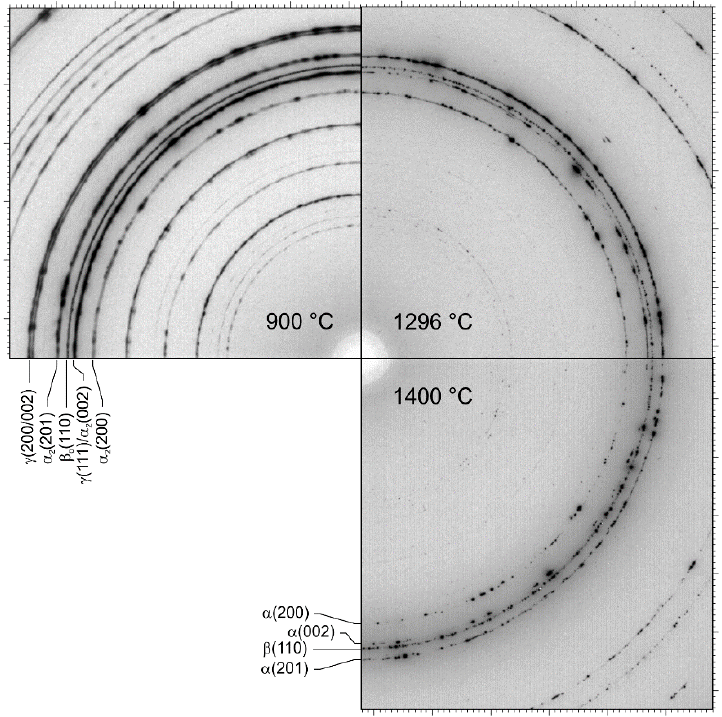
Figure 3. 90° sectors of detector images at three different temperatures during heating with 20 K min –1 (see